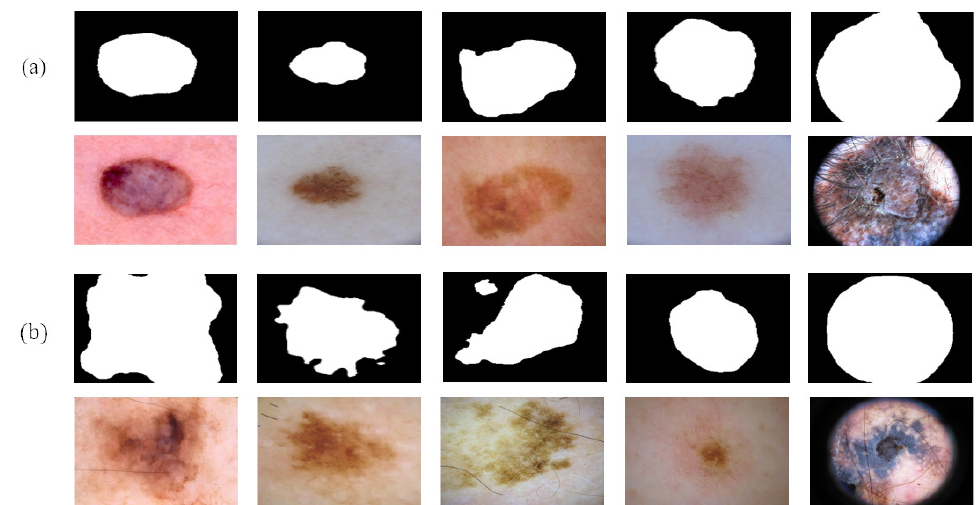
Figure 7. Comparison between reliable pseudo-labels and unreliable pseudo-labels: ( a ) reliable pseudo-labels, corresponding images, and ( b ) unreliable pseudo-labels, corresponding images.